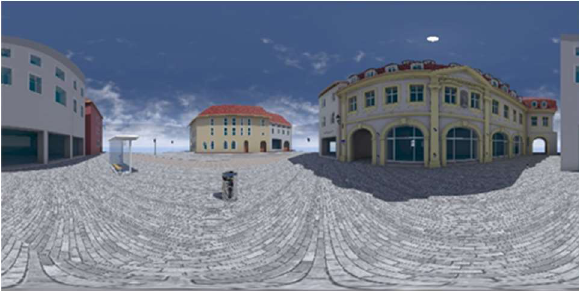
Figure 2 . Example of spherical panorama image, generated from simulator.